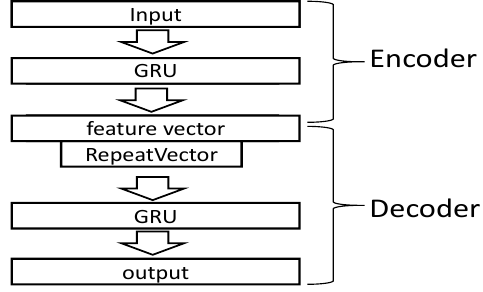
Figure 5. Sequence autoencoder network structure.